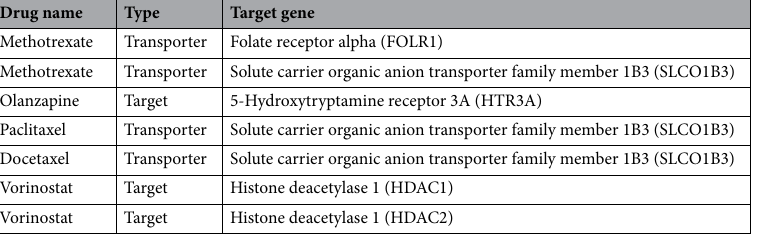
Table 2. Confirmation of the candidate drugs and candidate target genes thanks to the DrugBank